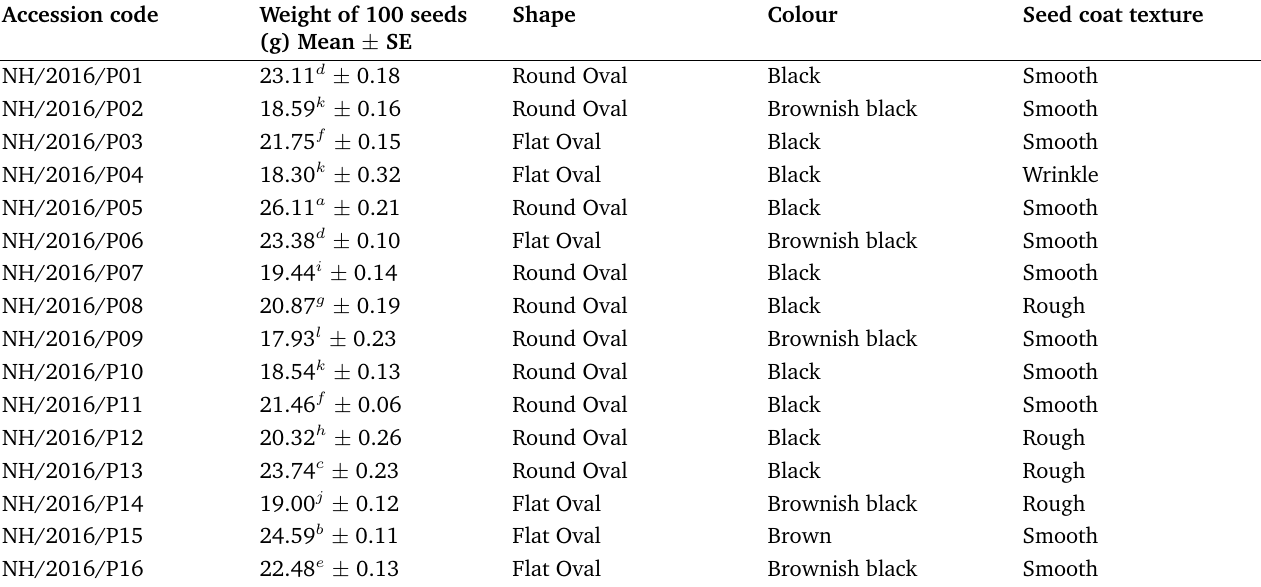
Table 3. Seed characteristics of Parkia biglobosa accessions used in this study. Values are mean ± Standard Error. Means within the same column with different letters are significantly (p ≤ 0.05)